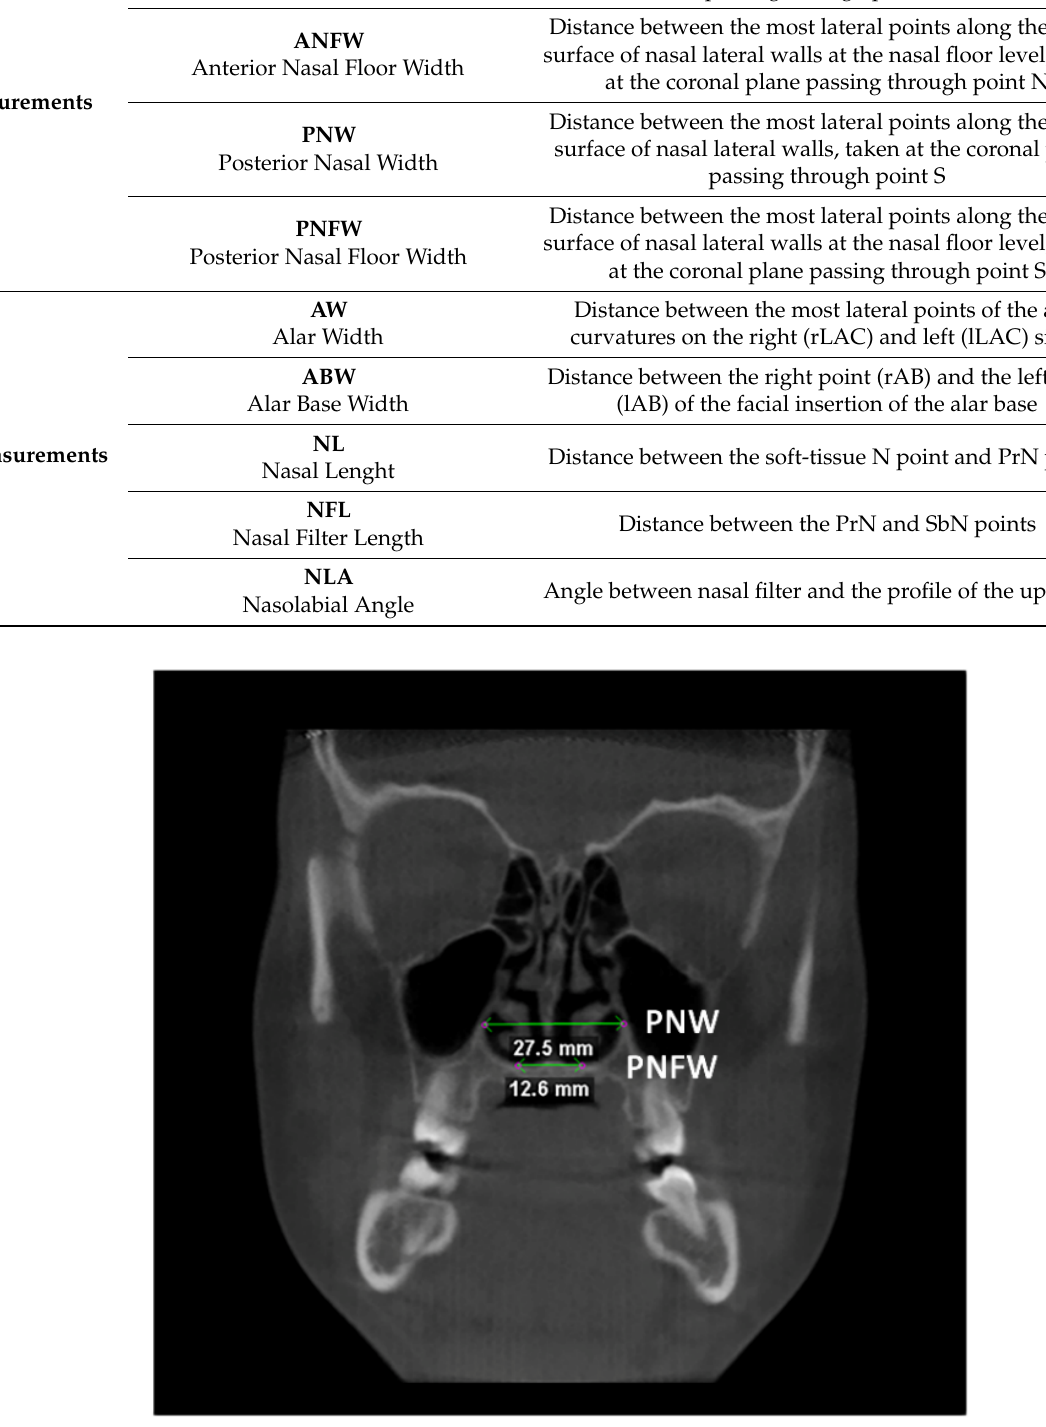
Figure 4. Linear measurements of the posterior nasal width (PNW) and the posterior nasal floor width (PNFW) in the coronal plane. Table 1. Description of the linear measurements used in the present study.